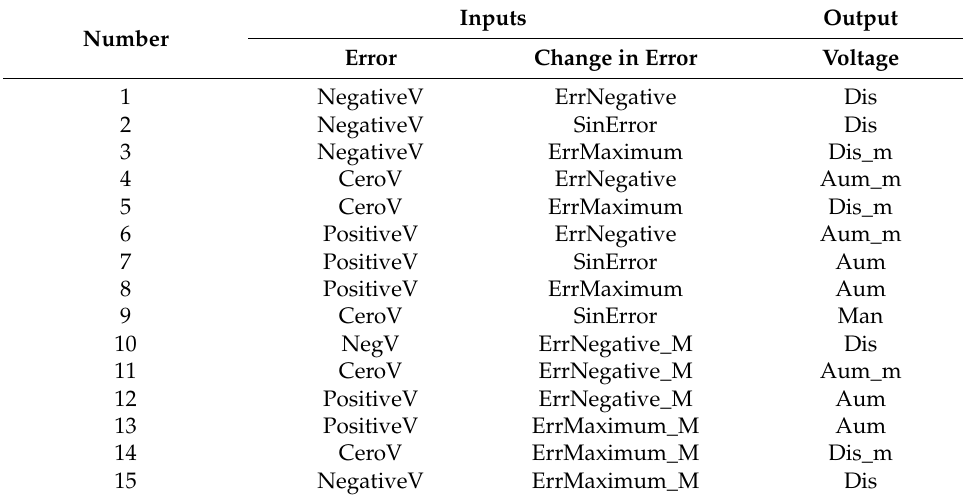
Table 4. Fuzzy rules for the motor controller.